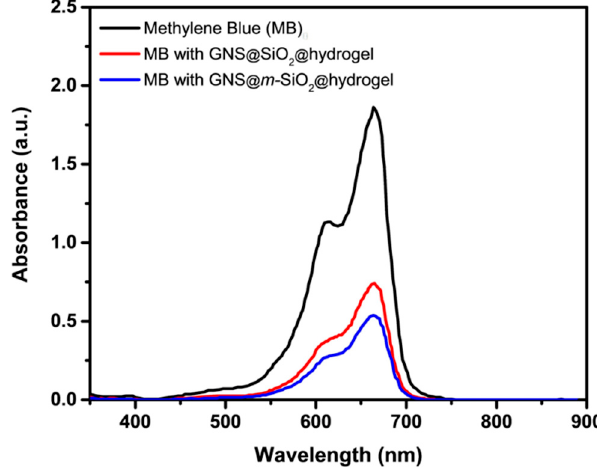
Figure 3. Ultraviolet–visible (UV–vis) spectra of 0.00002 M methylene blue (black) compared to the supernatant of the GNS@SiO 2 @hydrogel (red) and the GNS@ m -SiO 2 @hydrogel (blue).